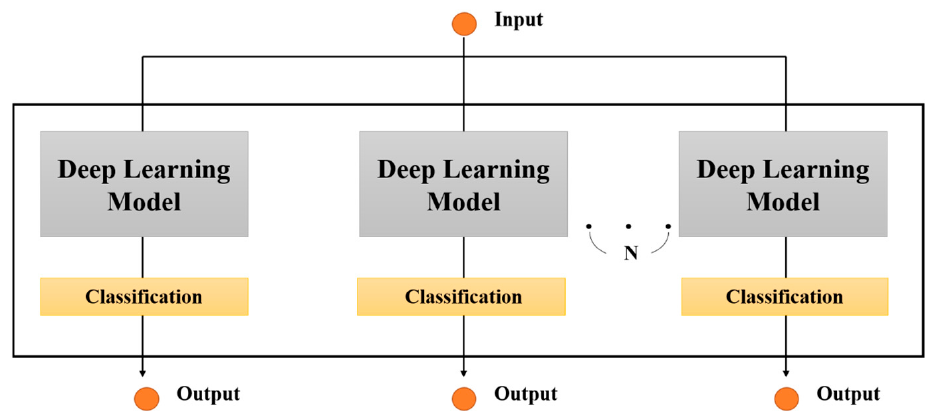
Figure 2. Multi model architecture of multi-label classification.